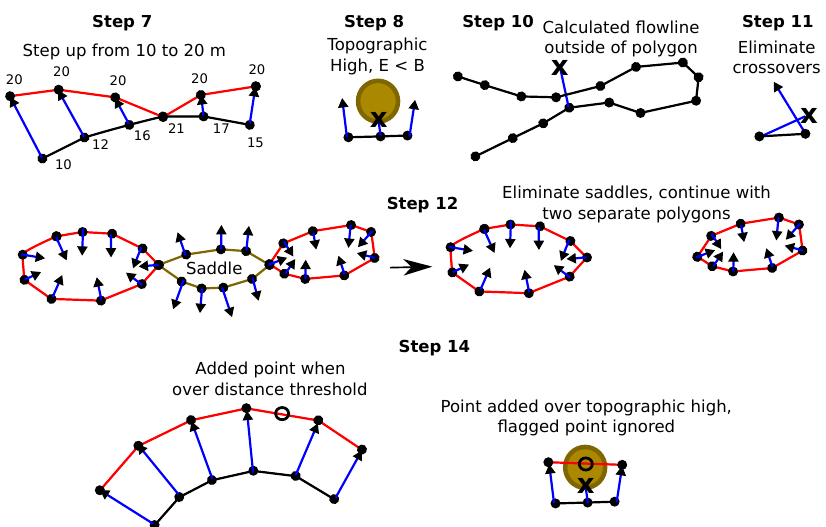
Figure 1. Schematic illustrating the steps in calculating the ice sheet, illustrating steps 7, 8, 10, 11, 12 and 14 in Sect. 2.2. The black lines indicate the initial elevation contour, blue lines indicate calculated flowlines, red lines indicate the next elevation contour, black circles indicate flowline initiation points, unfilled circles indicate added initiation points for the next elevation contour, crosses indicate flagged points that are not included in the next elevation